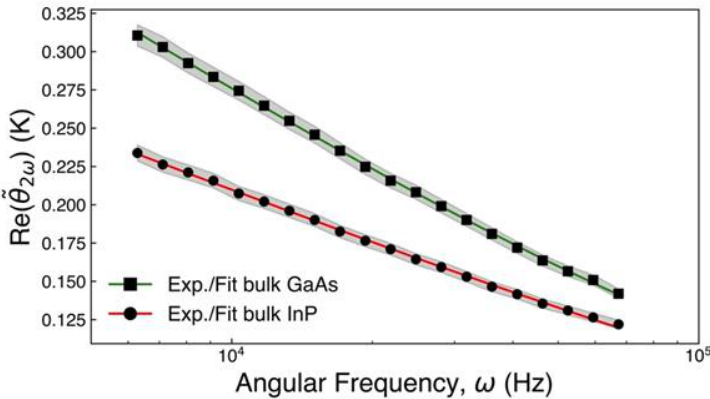
lines for both samples.